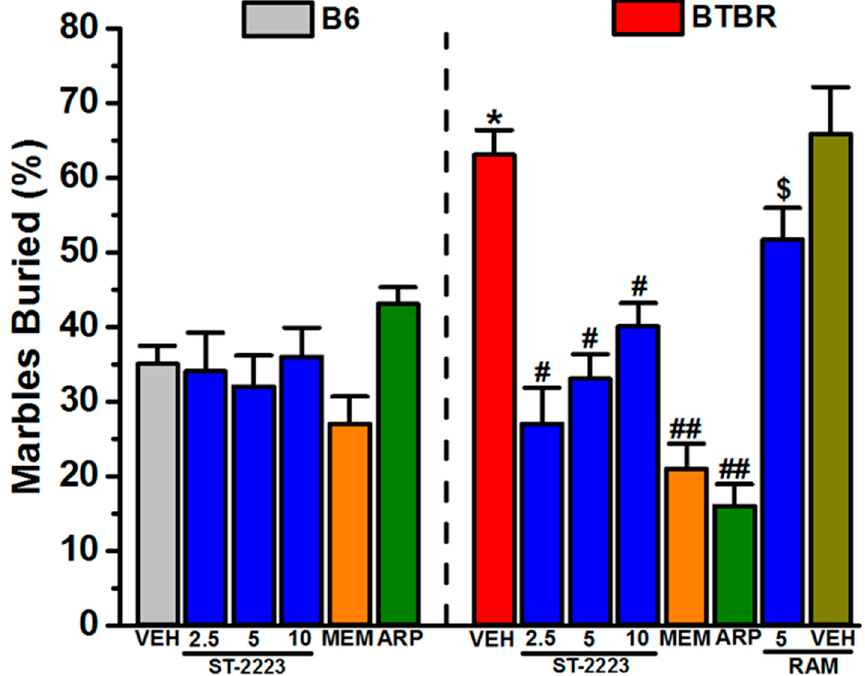
Figure 2. ST-2223 treatment attenuates marble burying in Black and Tan BRachyury (BTBR) mice. Percentage of marbles buried was assessed in B6 and BTBR mice. Each mouse received an i.p. injection of vehicle, ST-2223 (2.5, 5.0, or 10 mg/kg, i.p.), memantine (MEM, 5 mg/kg, i.p.), or aripiprazole (ARP, 1 mg/kg, i.p.) 30–45 min prior to marble exposure. BTBR mice buried significantly more marbles compared to B6 mice. Vehicle or ST-2223 treatment did not significantly affect marble burying in B6 mice. ST-2223 (2.5, 5, and 10 mg/kg, i.p.) and MEM significantly decreased marble burying in BTBR mice. The effects of systemic co-injection of ( R )- α -methylhistamine (RAM,(10 mg/kg, i.p.) on the ST-2223 (5 mg)-induced decrease in stereotyped repetitive and compulsive behaviors of BTBR mice were also assessed. Data are expressed as the mean ± SEM ( n = 5). * p < 0.05 vs. vehicle-treated B6 mice. # p < 0.05 vs. vehicle-treated BTBR mice. ## p < 0.01 vs. vehicle-treated BTBR mice. $ p < 0.05 vs. ST-2223 (5 mg)-treated BTBR